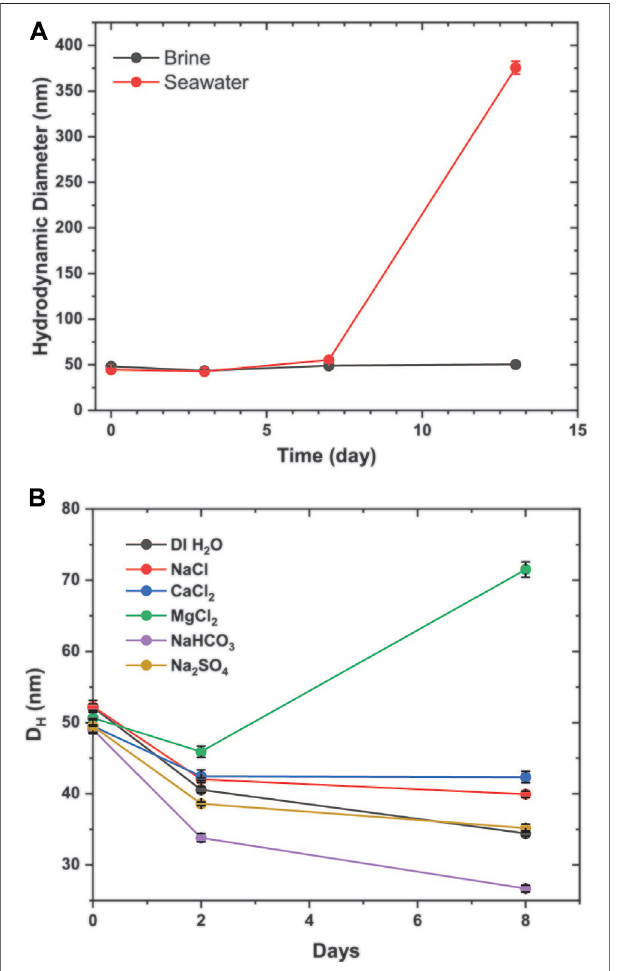
FIGURE 3 | (A) Time-lapse images of Dex-SPIONS dispersed in the following brine compositions (left-to-right, per time point): 0.5 M MgCl 2 , 0.5 M MgCl 2 /0.05 M CaCl 2 , 0.5 M MgCl 2 /0.1 M CaCl 2 , 0.5 M MgCl 2 /0.2 M CaCl 2 , and 0.5 M MgCl 2 /0.5 M CaCl 2 . (B) DLS graph showing average hydrodynamic diameter as a function of time spent under heating at 103 °